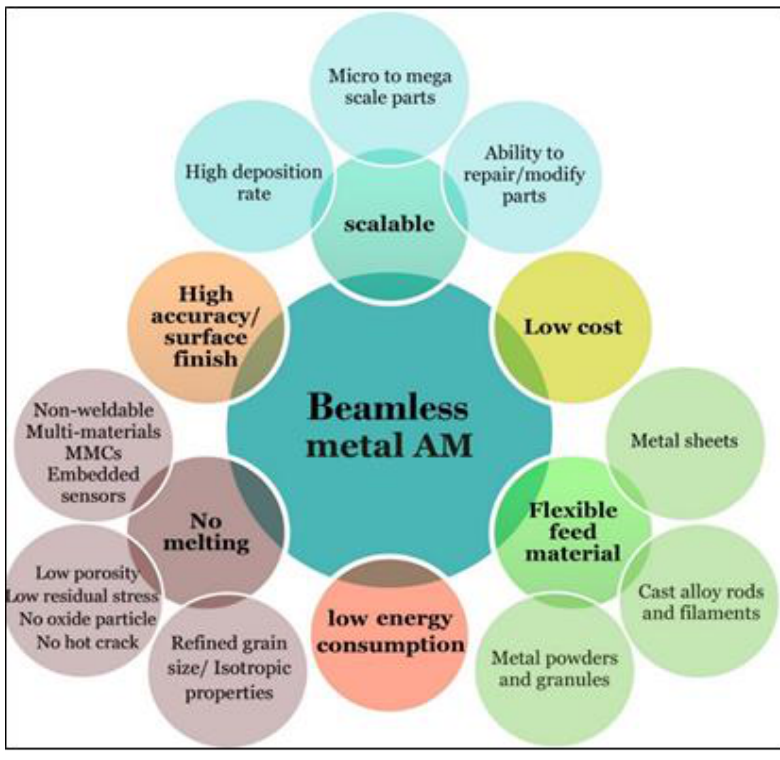
Figure 12. The main possibilities and advantages of the beamless metal-AM over beam-based systems they are low energy, can achieve higher dimensional accuracy, can be used for printing parts from micro to mega scale parts with improved mechanical properties as they do not comprise material melting and rapid solidification.